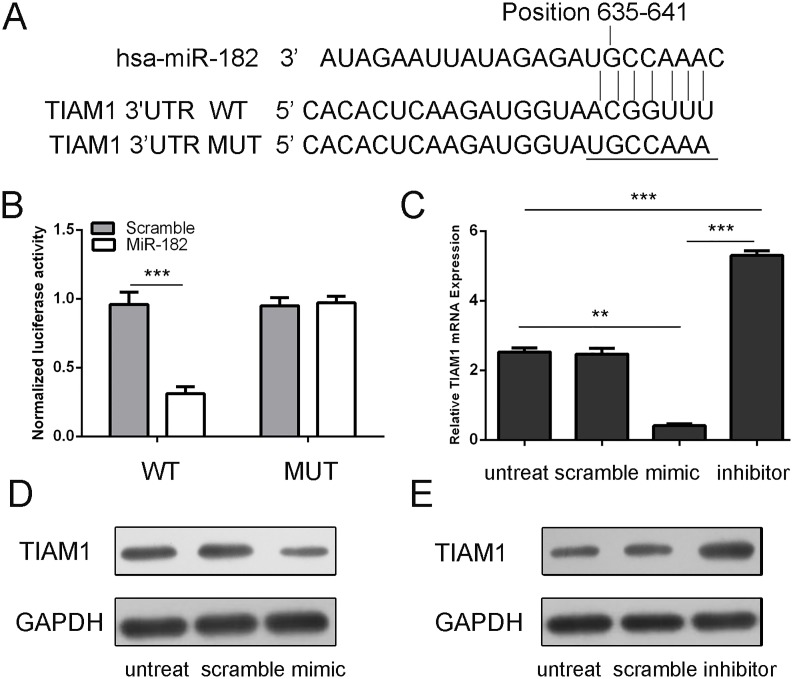
miR-182 directly targets the TIAM1 in osteosarcoma cells.(A) The potential miR-182 binding site at the 3'-UTR of TIAM1 mRNA was computationally predicted by Targetscan. (B) Cells were transfected with wild type 3'-UTR reporter or mutant constructs together with 20 nM of miR-182 mimics or controls. Luciferase activity was normalized by the ratio of firefly and Renilla luciferase signals. (C) Relative expression of TIAM1 in the MG-63 cells transfected with miR-182 mimics or negative control or inhibitor. The expression of TIAM1 was normalized to GAPDH. (D) Western blot analysis of TIMA1 expression in MG-63 cells transfected with miR-182 mimics or negative control or untreat group. GAPDH was also detected as a loading control. (E) Western blot analysis of TIAM1 expression in MG-63 cells transfected with miR-182 inhibitor or negative control or untreat group. GAPDH was also detected as a loading control. ***p<0.001.